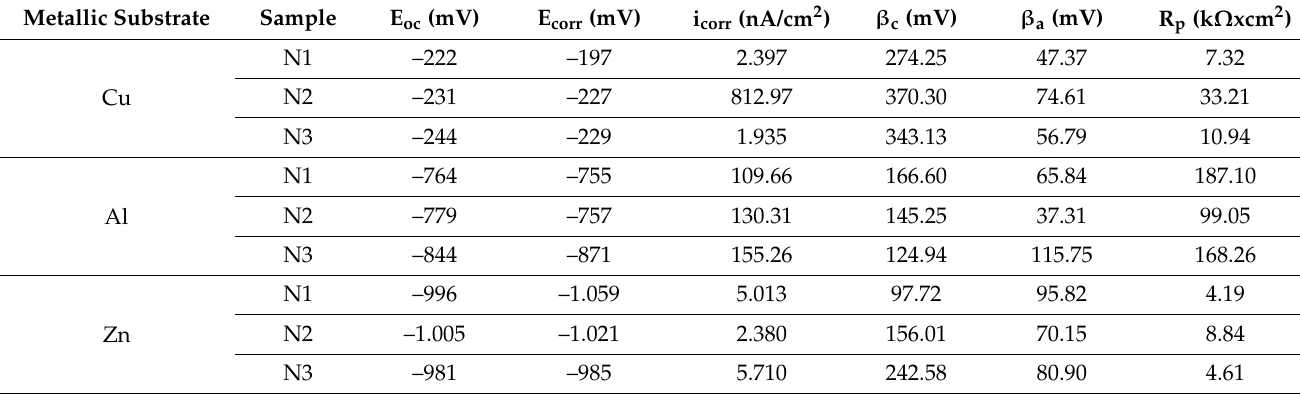
Table 3. The main electrochemical parameters of the investigated samples.